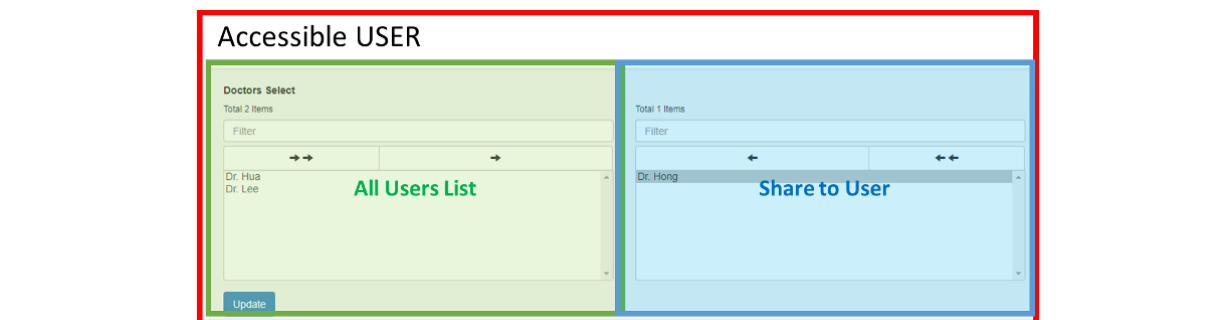
Figure 10. Authority control user